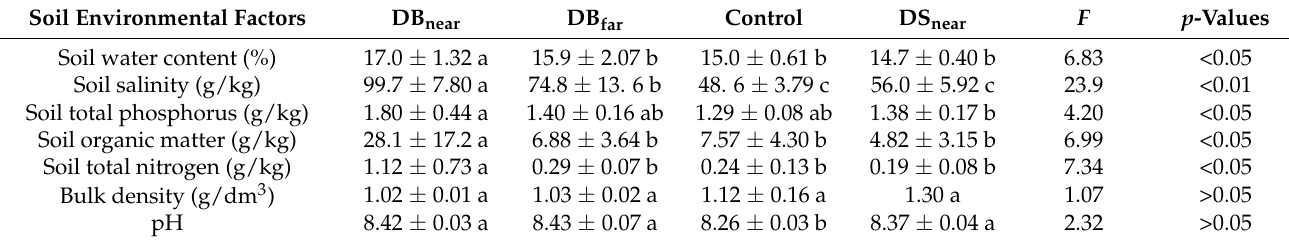
Table 1. Differences in soil environmental factors among the four plot types tested by one-way ANOVA (mean ± SD). The different lowercase letters after the Mean values indicate a significant difference ( p < 0.05) in soil environmental factors among the four plot types, whereas same lowercase letters show no significant differences ( p > 0.05).